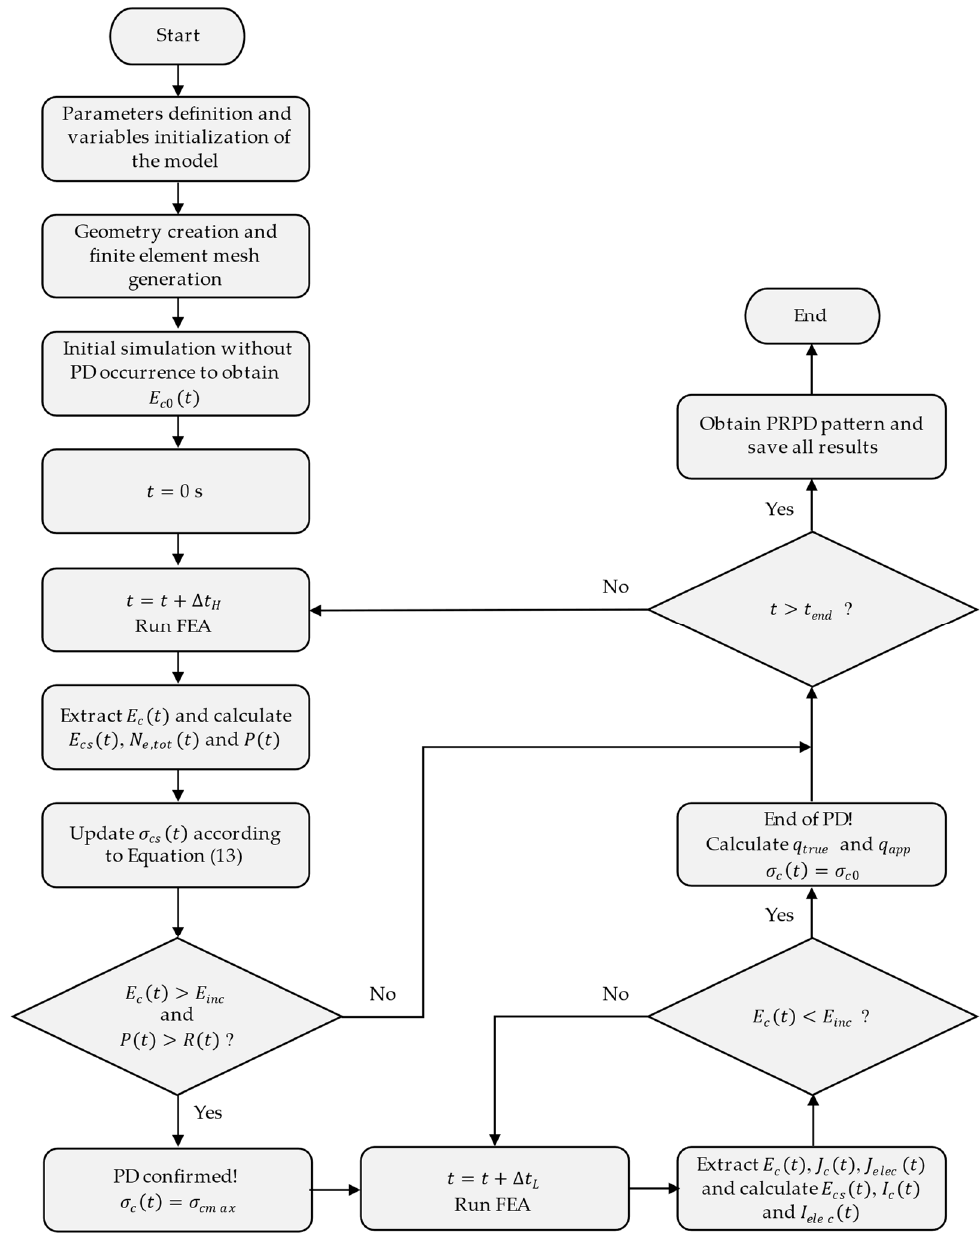
Figure 3. Flowchart of the algorithm implemented to simulate PDs in an internal air cavity.